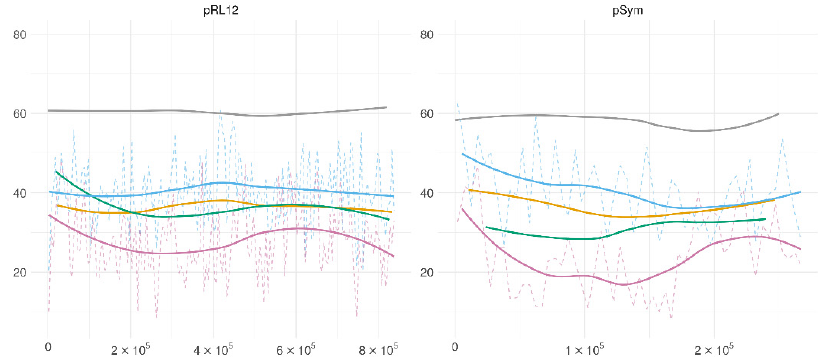
Figure 5. GATC methylation across the replicons. Green—GATC methylation in bacteroids, violet—methylation in cell culture, purple—methylation of cytosine in bacteroids, blue—methylation of cytosine in bacteroids, grey—GC content. Solid lines—polynomial regression lines calculated using the ggplot_smooth “loess” method, formula “y~x”, dotted lines—the average methylation across a 5 kb sliding window.